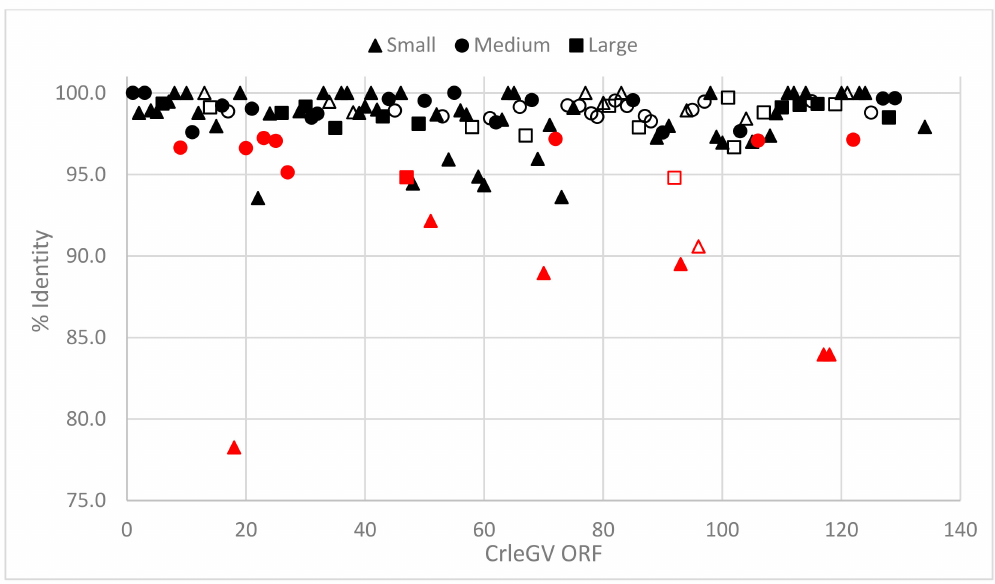
Figure 3. Scatter graph of the percentage identity between ORFs in CrleGV-SA (2015) and CrleGV-CV3, grouped by amino acid length. Triangles are ORFs < 200 AA, circles are ORFs > 200 but < 400 AA, and squares are ORFs > 400 AA. Core genes are shown with shape outlines only, while outliers for each group are coloured